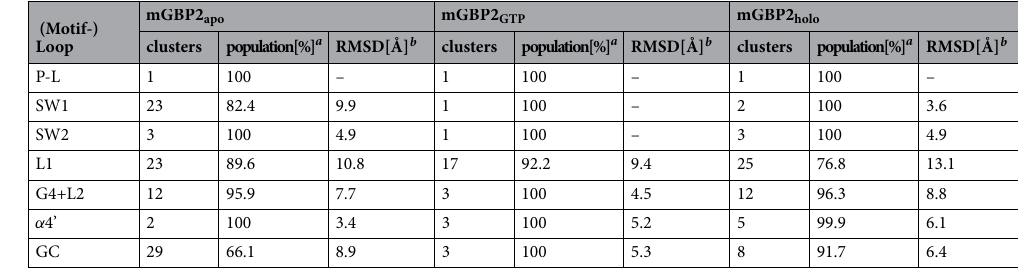
Table 1. Flexibility of the G domain loops of monomeric mGBP2 determined by clustering of the a conformations sampled in the HREMD target replica. Percentage of the structures, which are cumulatively b represented by the first three clusters. The largest RMSD found between two